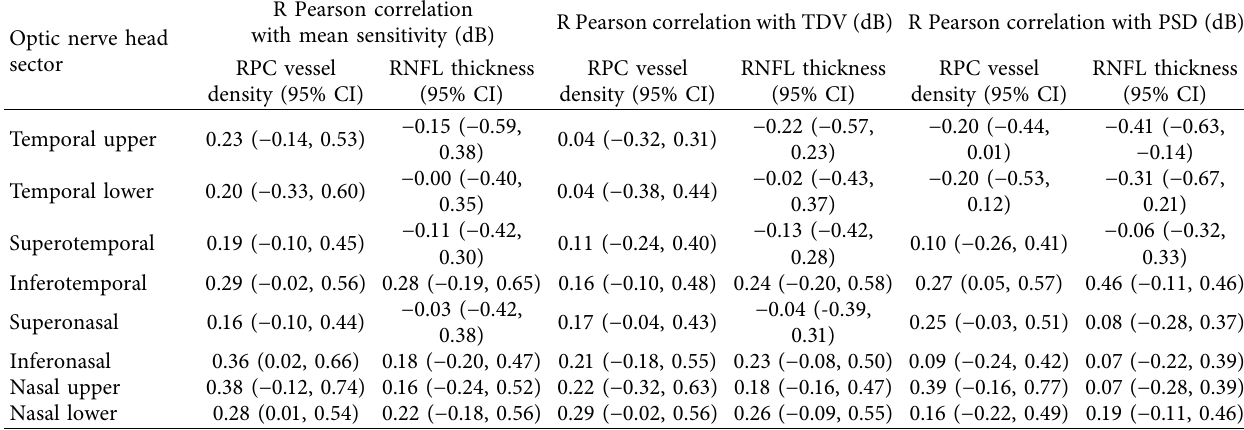
Table 5: Correlations of the RPC vessel density and RNFL thickness with the mean sensitivity, TDV, and PSD in the corresponding optic nerve head sector for glaucoma suspect subjects. R Pearson correlation R Pearson correlation with TDV (dB) R Pearson correlation with PSD with mean sensitivity (dB)